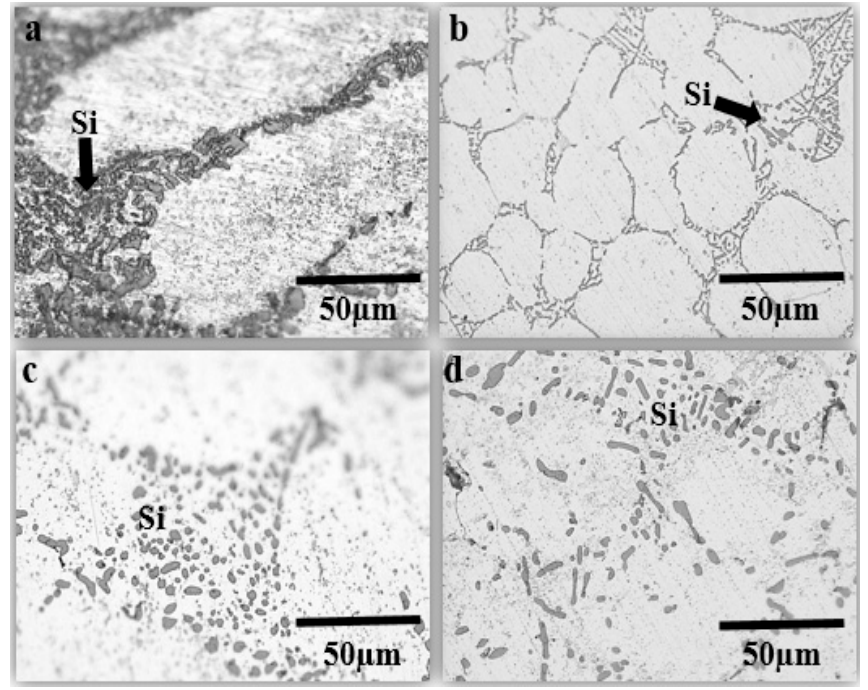
Figure 3. Microstructure of eutectic phase: ( a ) as-cast, ( b ) cooling slope, ( c ) as-cast-T6 and ( d ) cooling slope-T6.